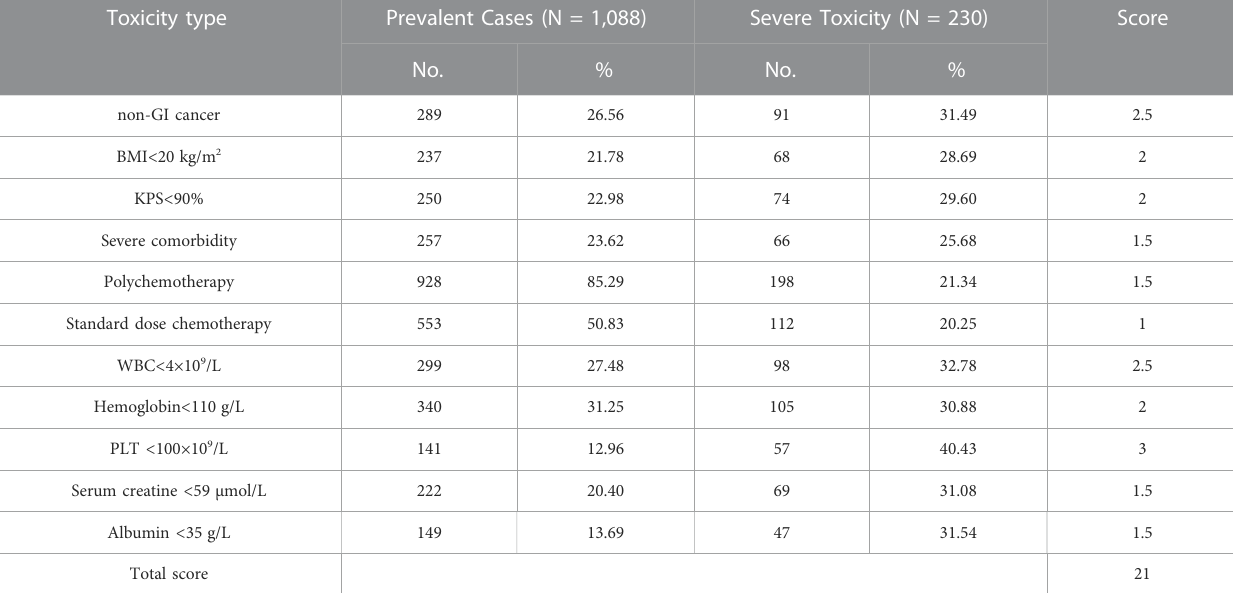
TABLE 4 Chemotherapy-related toxicity predictive model.